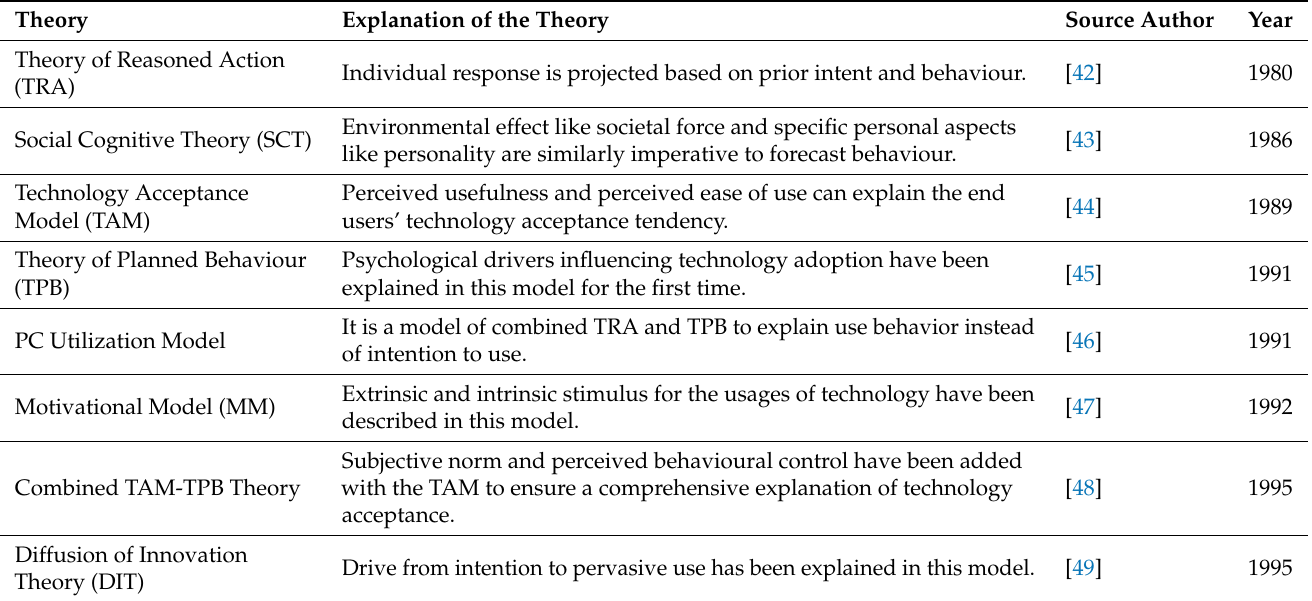
Table 1. Base theories of the unified theory of acceptance and use of technology (UTAUT) model.